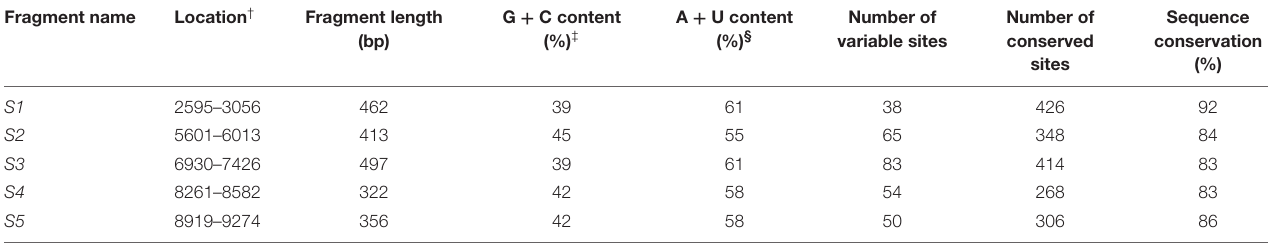
TABLE 1 | Characteristics of the identified five conserved target fragments in Soybean mosaic virus (SMV) genome based on multiple sequence alignment.